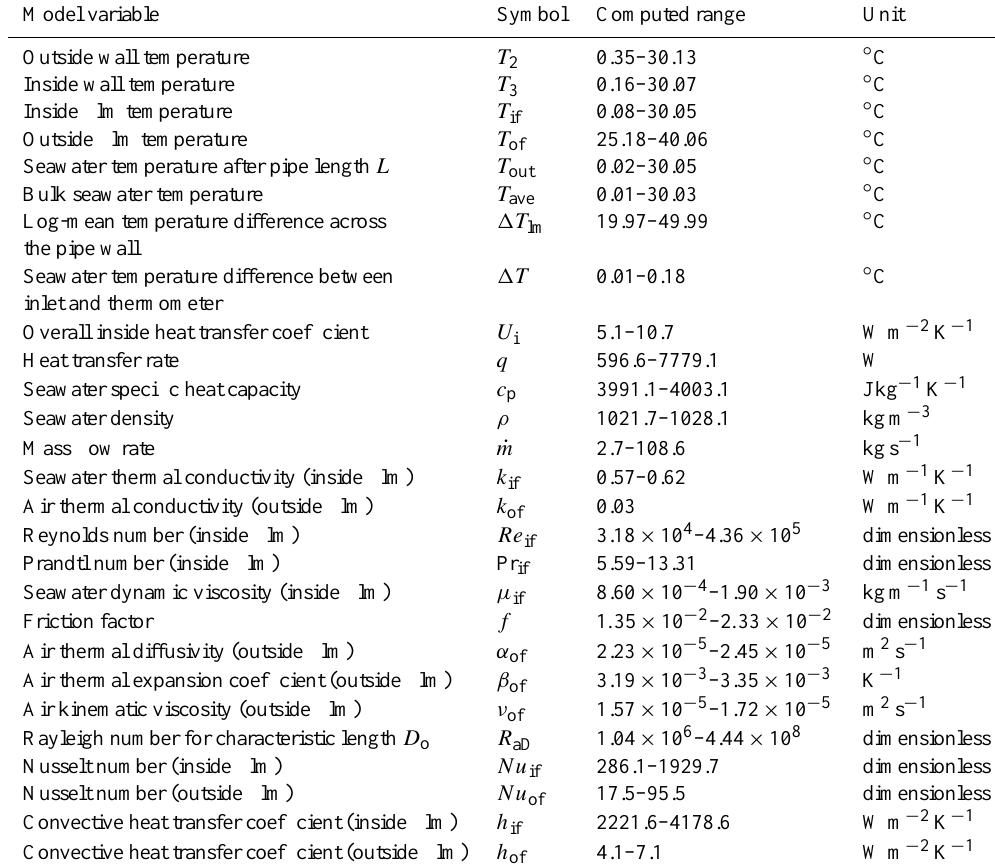
Table A4. Variables computed by the seawater intake warming model including their calculated range in Fig. A3. Model